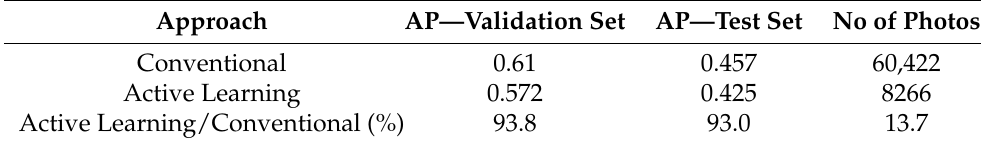
Table 3. Comparison of models trained conventionally and using Active Learning